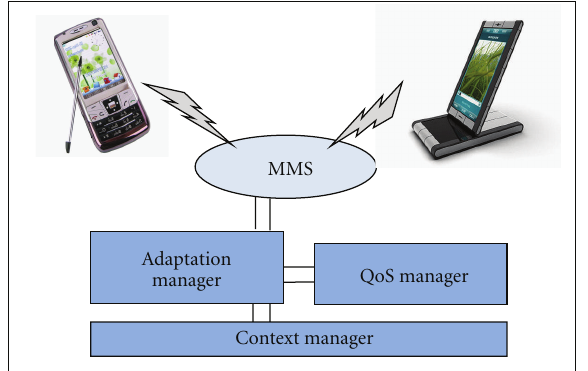
Figure 20: Design adapted